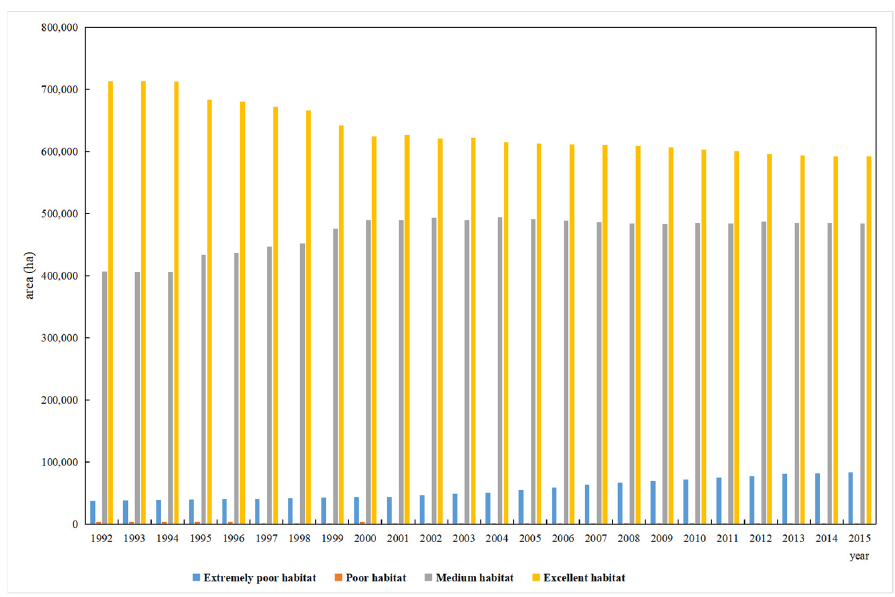
Figure 2. Statistical chart of habitats of different qualities in Wenzhou City from 1992 to 2015. The spatial distribution of habitat quality in Wenzhou City considerably differs.